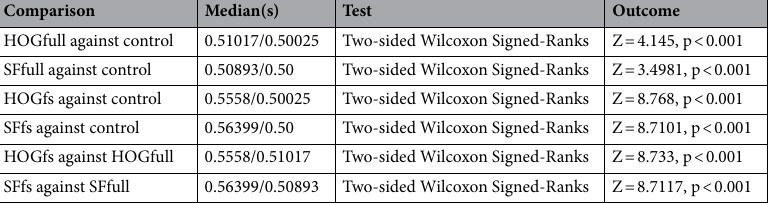
Table 1. Statistical test outcome: accuracies different expressions